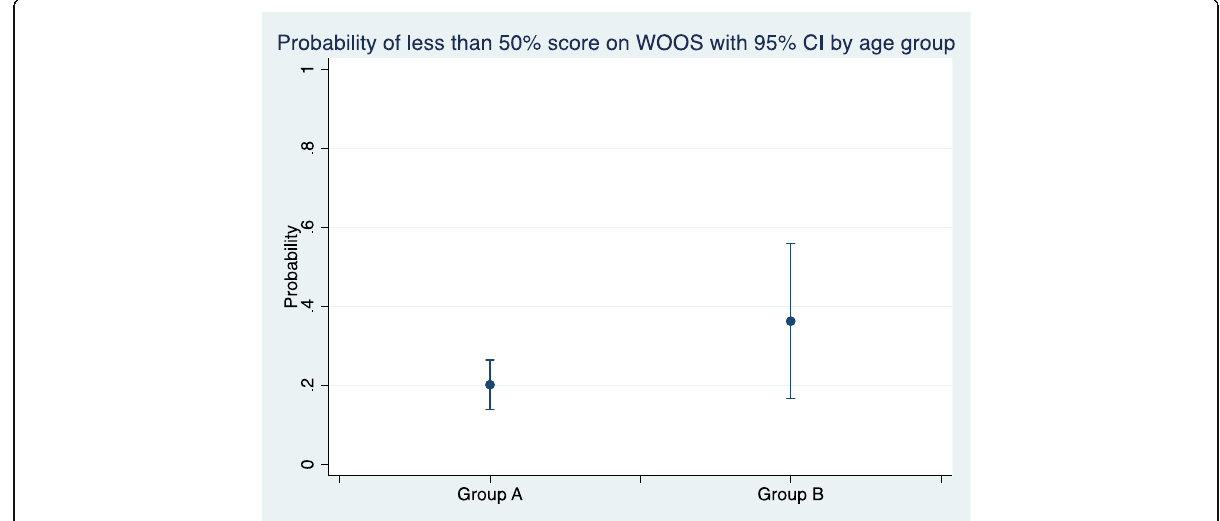
Fig. 4 The probability of not reaching a clinically relevant results in a score higher than 50%, according to the Danish version of WOOS. There was no significant difference between the two age